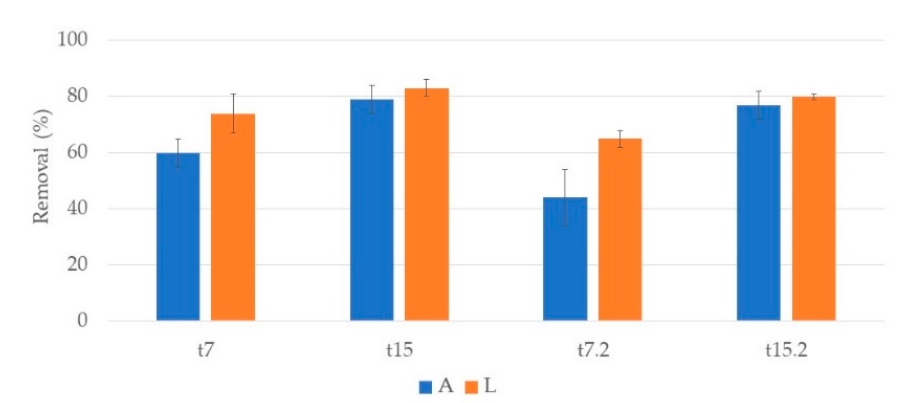
Figure 12. Removal percentage and respective standard deviation (n = 3) of COD, in CWs with T. latifolia and expanded clay (A) or lava rock (L) over the two cycles of treatment. First cycle: samples taken after one week (t7) and at the end of the two-week cycle (t15). Second cycle: samples taken after one week (t7.2) and at the end of the two-week cycle (t15.2).